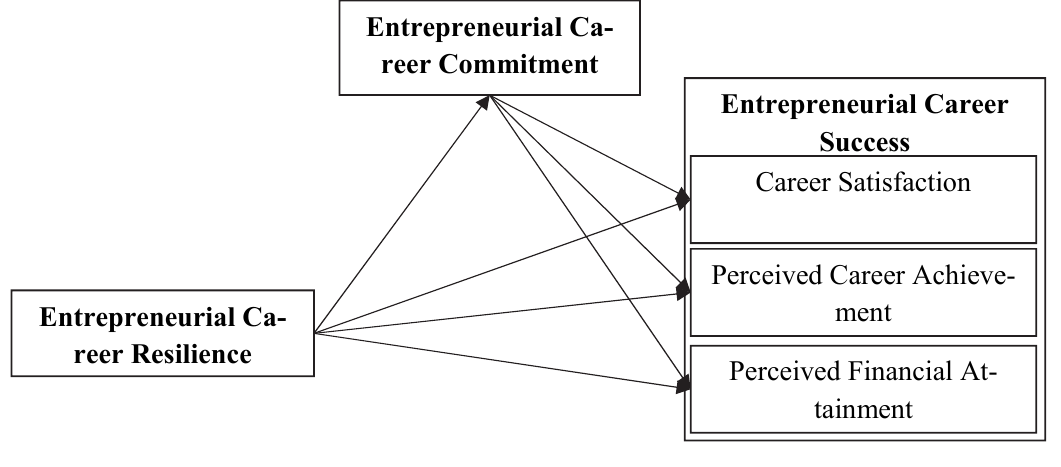
Fig. 1 . Hypothesized